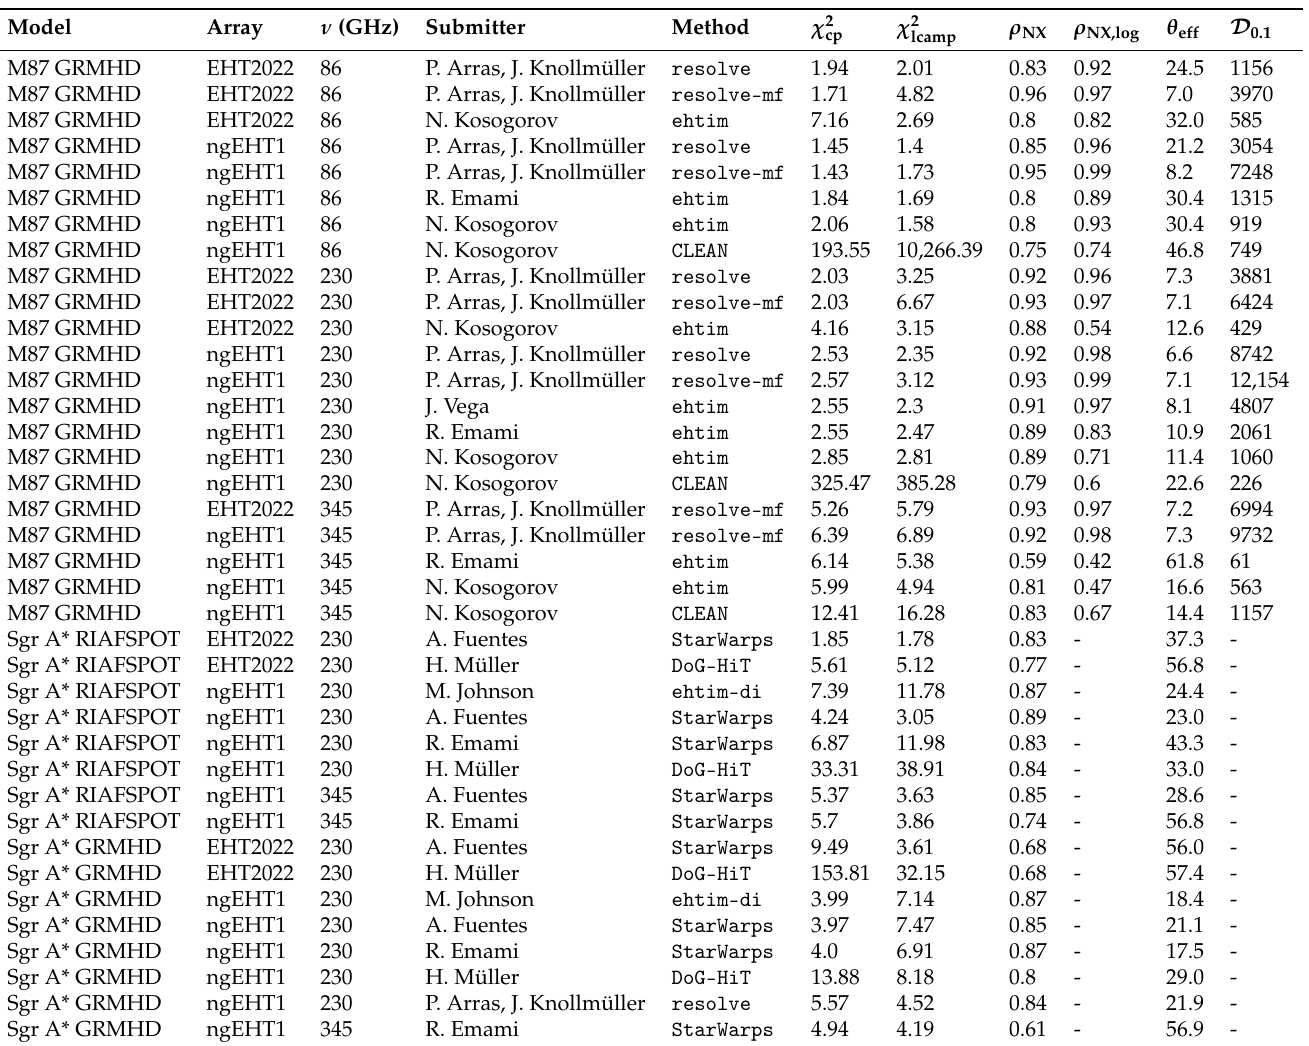
Table 2. Reconstruction quality metrics for Challenge 2. Tabulated values are medians across the reconstructed frames except for the resolve-mf reconstructions, which were only done for the first movie frame. For the Sgr A* models, the metrics were evaluated on a common UT range for all reconstructions (see text for